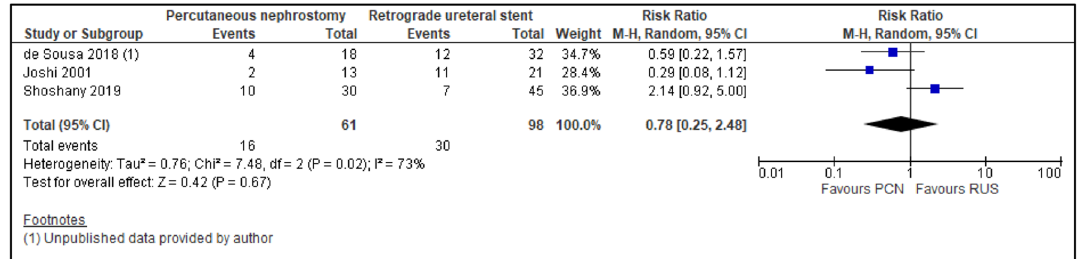
Figure 7. Comparison between PCN and RUS for outcome QoL – mobility.